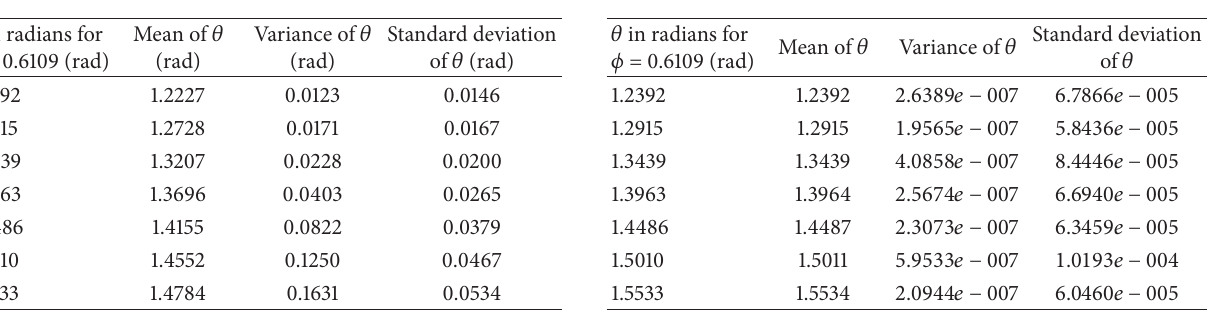
Table 12: Means, variances, and standard deviations at 10dB noise for different elevation angles and fixed azimuth angle by using GA- PS with 2-L-shape